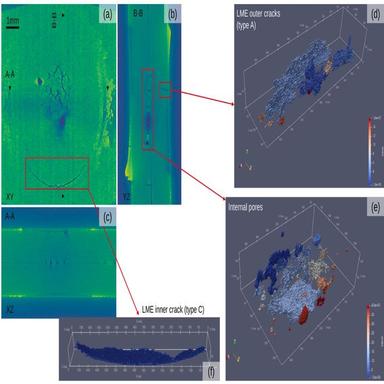
Loaded-crack sample at the first load step of 17.4 kN, as reconstructed from X-ray tomography. a-c) Slices in the weld volume and d-f) 3D views of the different types of defects. XY, XZ and YZ planes refer to the reference frame depicted in